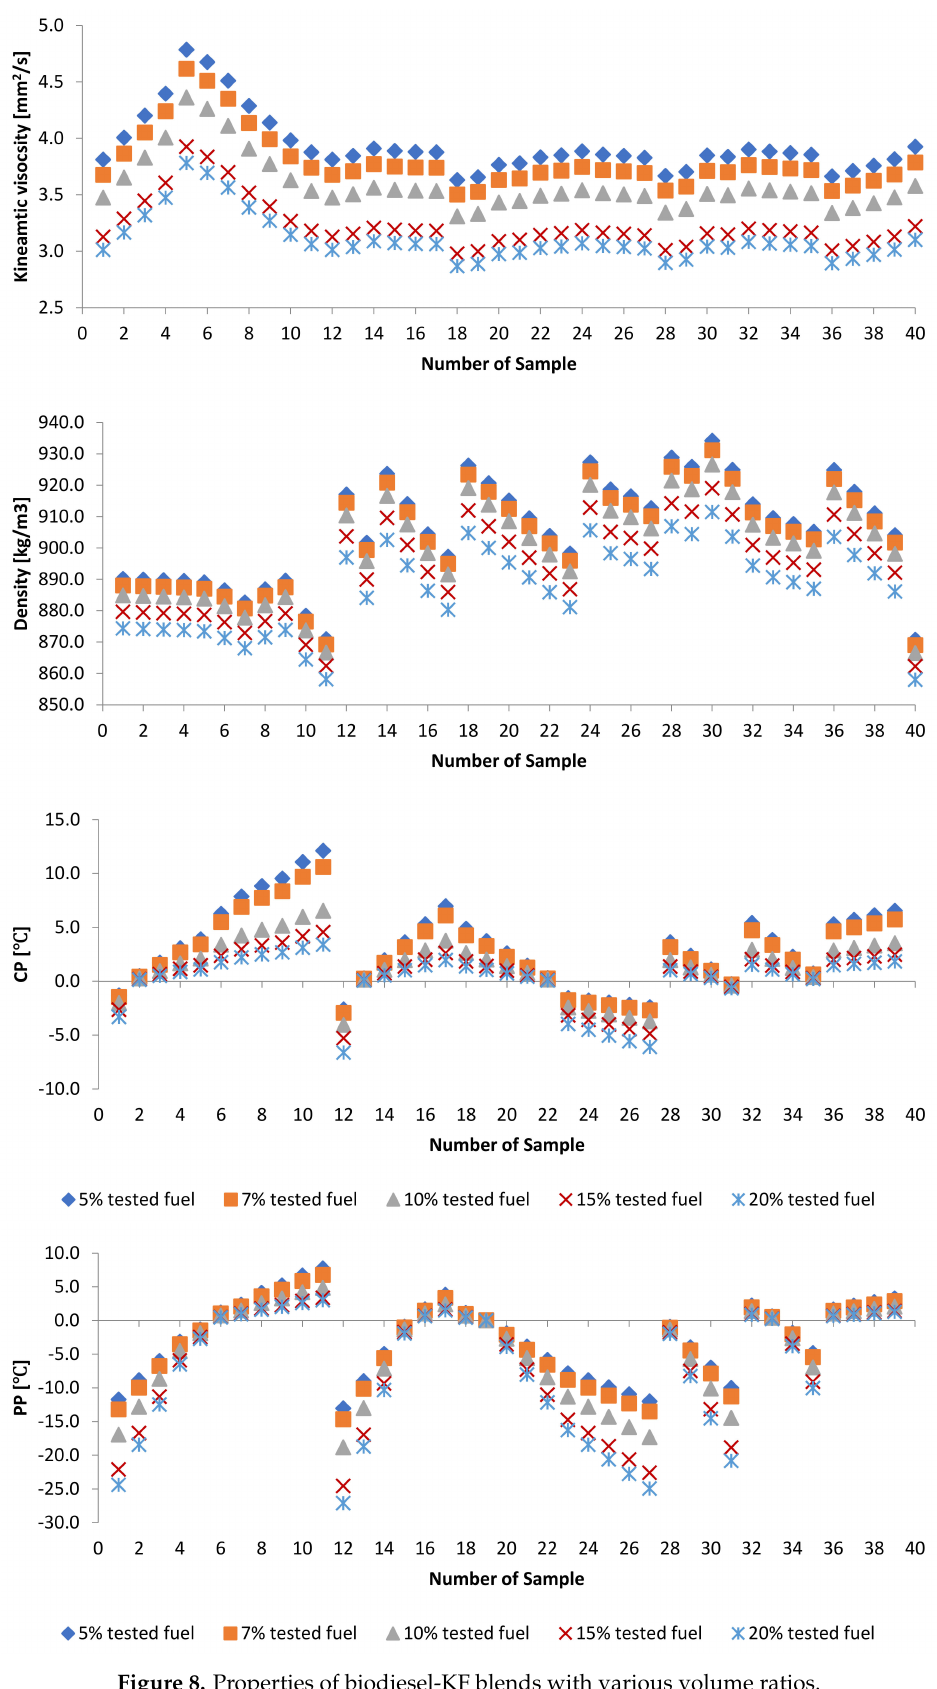
Figure 8. Properties of biodiesel-KF blends with various volume